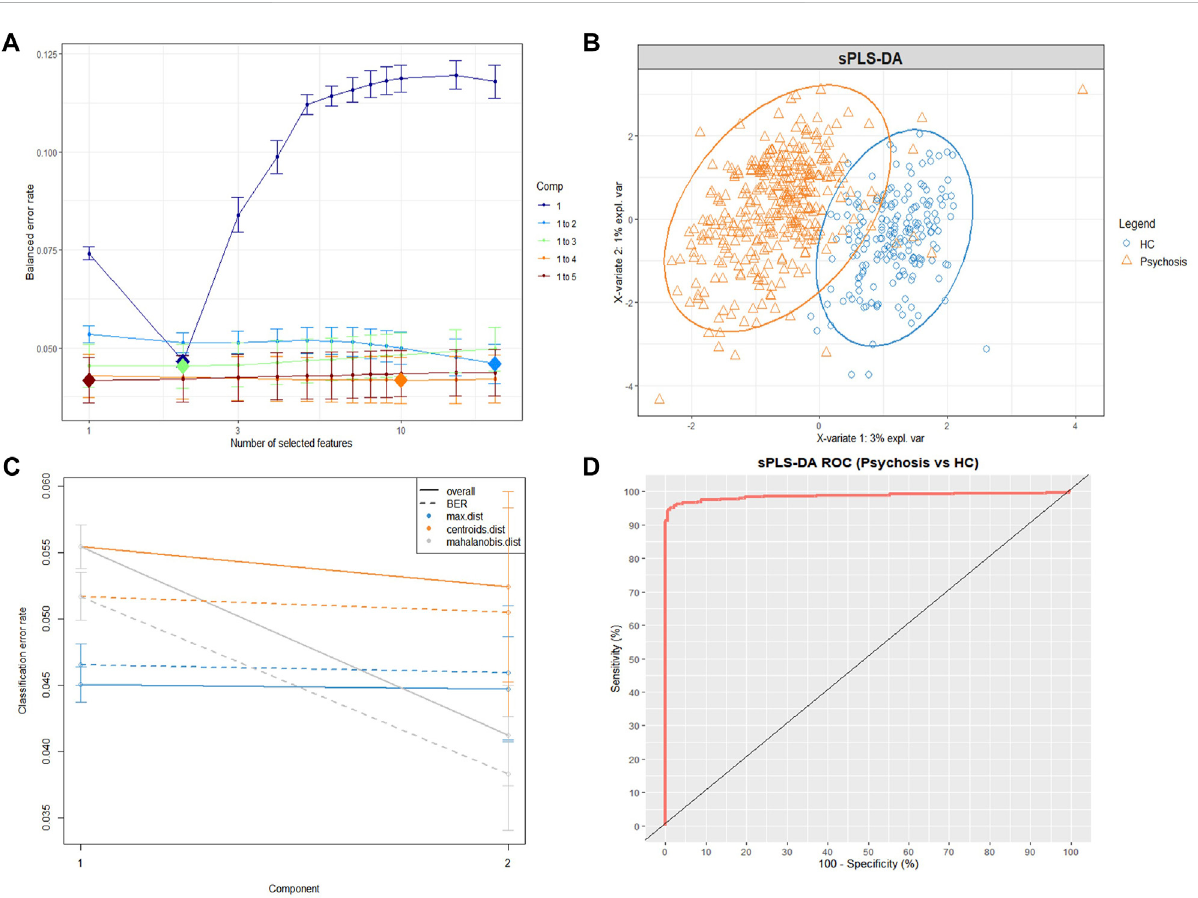
FIGURE 1 The sPLS-DA model for differentiating psychiatric patients and healthy controls using lipidomic data. (A) Balanced error rates (BERs) decreased when more components were added to the tuning sPLS-DA model. Here, the fi rst 2 components (light blue line) were suf fi cient to achieve good performance (error rate = 0.046 ± 0.005, 1,000×7-fold cross-validation), and the optimal features of each component are indicated as a diamond plot. (B) The sPLS-DA sample plot with ellipse circles indicating the 95% con fi dence interval. The fi rst two components of the sPLS-DA model differentiating thepsychiatric patient group (orange triangle)fromthe HCgroup(blue circle). (C) Classi fi cation performance per component (overall andBER)forthreepredictiondistancesusingrepeatedcross-validation(1,000×7-fold).Alltheclassi fi cationerrorrateswerelowerthan0.06. (D) The ROC curve of the sPLS-DA model, and the AUC = 0.986. sPLS-DA , sparse partial least squares discriminant analysis; ROC , receiver operating curve; AUC , area under the receiver operating curve; HC , healthy control group; Psychosis , psychiatric patient